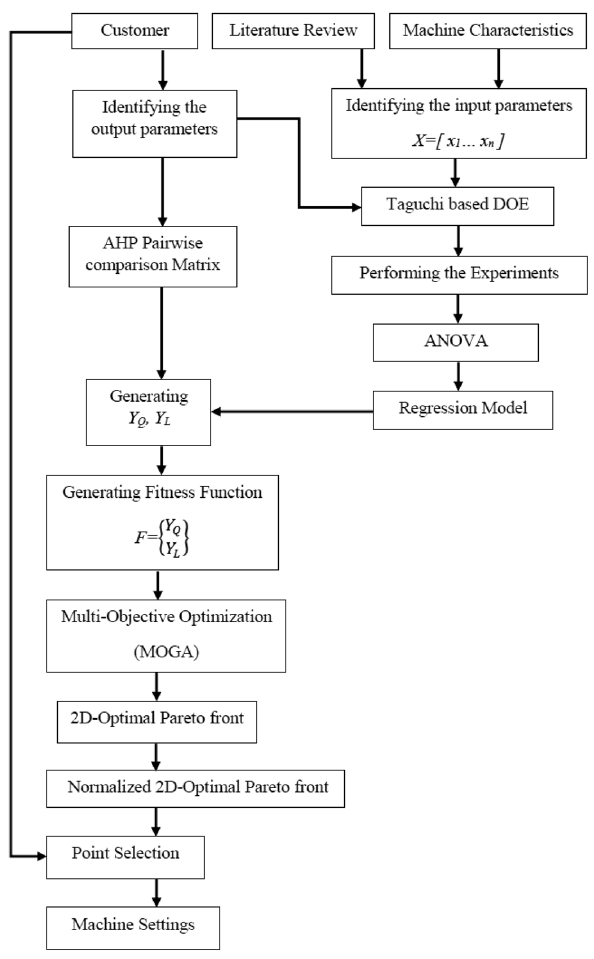
Fig. 1 Flowchart of the proposed